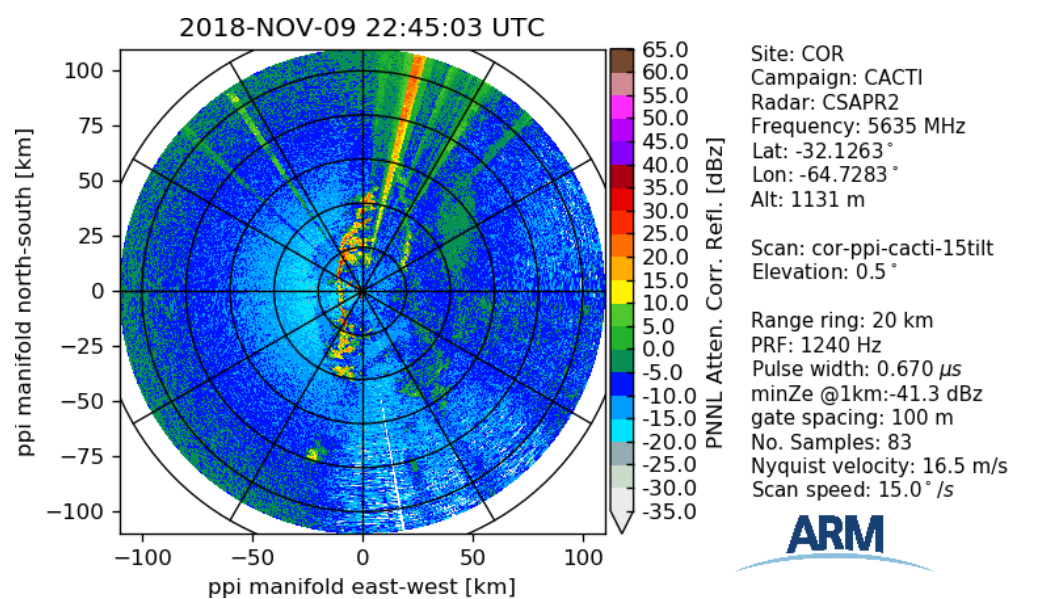
Figure 3. The CACTI CSAPR2 PPI from 9 November 2018 at 22:45:03UTC. The Sierras de Córdoba lie west of the radar, visible in the ground clutter signature. There is also significant clutter due to the hills to the east of the radar. There are also three interference sources visible to the northeast and the northwest. The northwestern source is attributable to a transmission tower, while the northeastern source is the town of